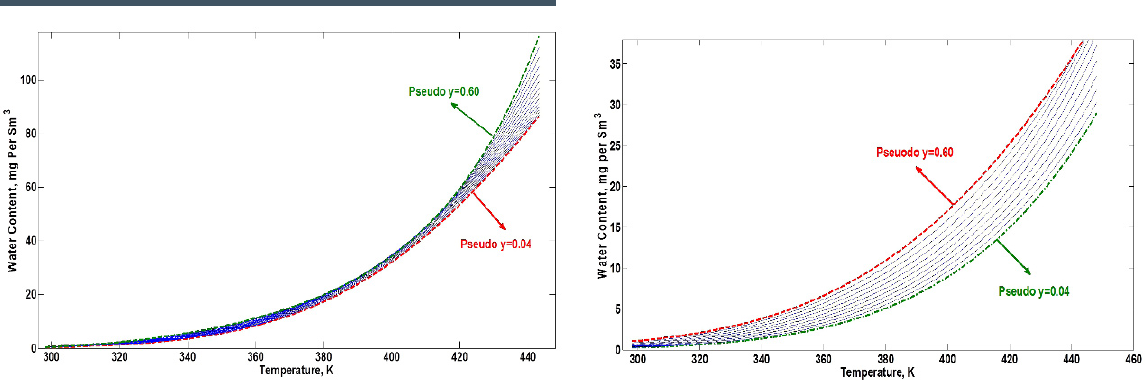
Figure 5. Prediction of water content of sour natural gases and acid gas mixtures at 41000 kPa (abs).